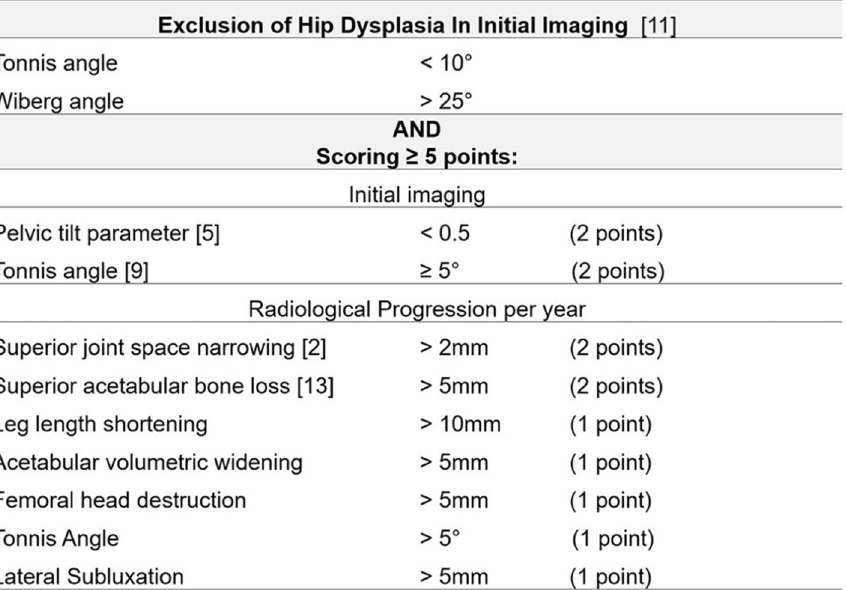
Table 1 The proposed rapidly progressive osteoarthritis diagnostic criteria